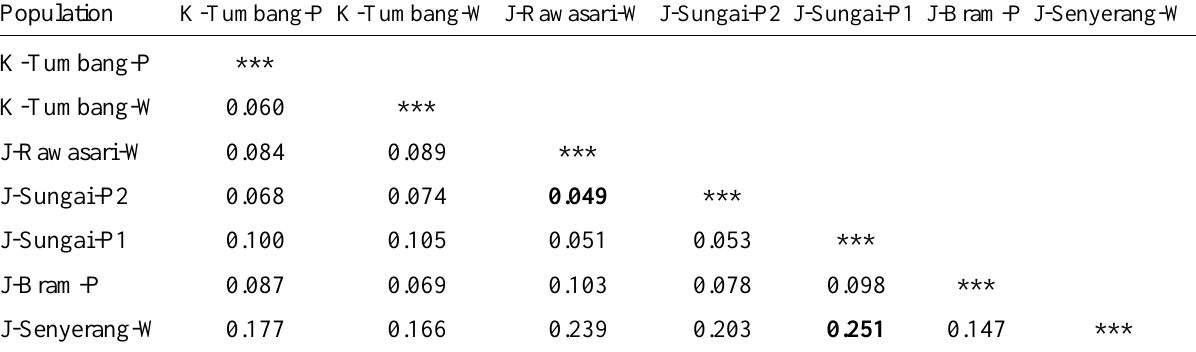
Table 4. Genetic distances between the seven populations of Dyera polyphylla . The population codes are explained in Table 1.